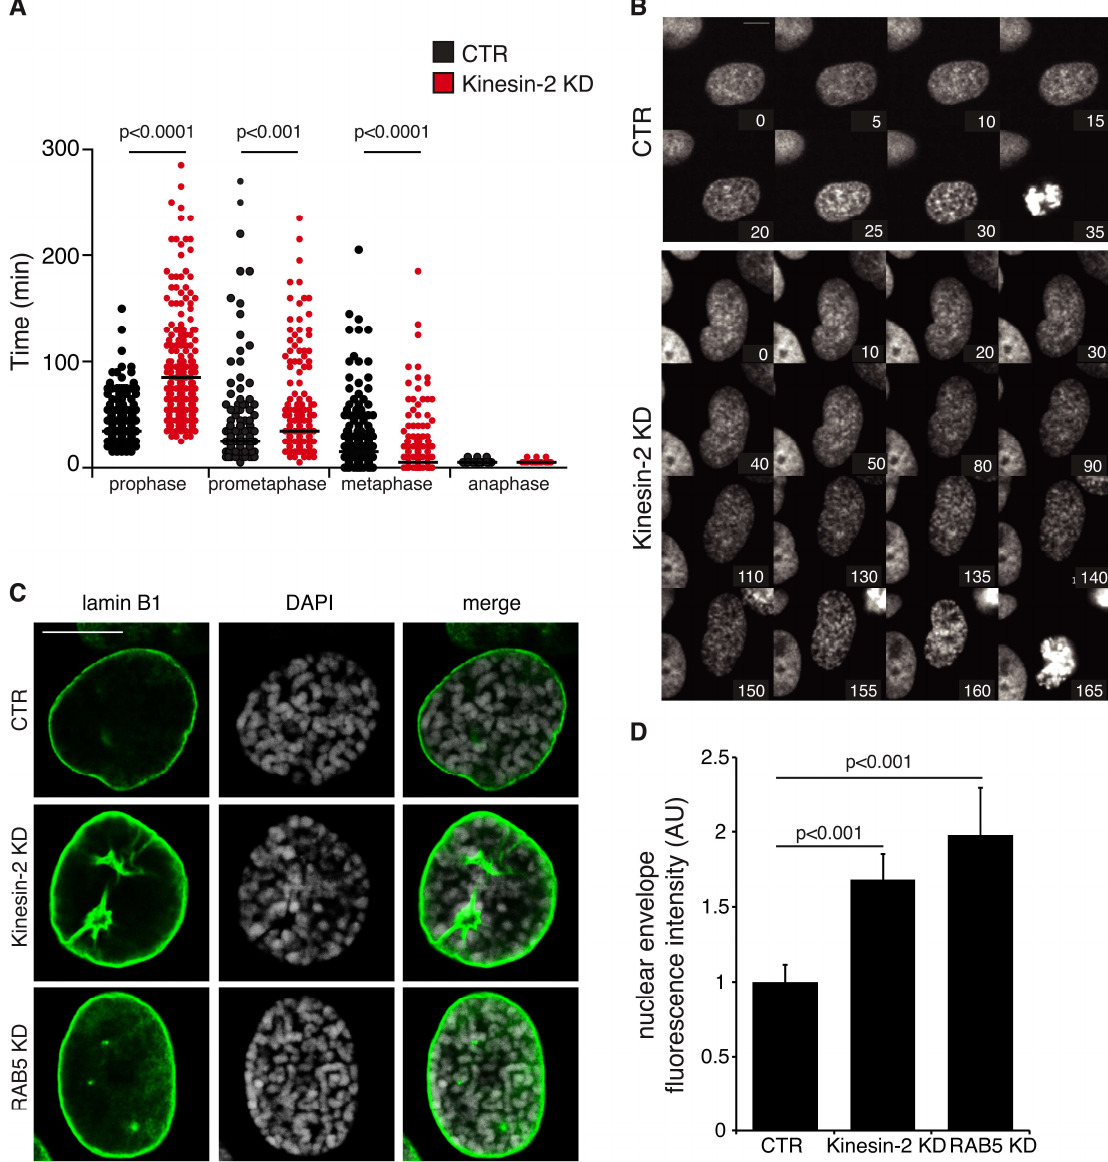
Figure 4. Kinesin-2 depletion delays prophase and nuclear envelope breakdown. ( A ) Scatter plot showing the time spent in the different mitotic phases (indicated below) by U2OS cells silenced with control oligo (CTR, n = 198 in black) or with KIF3A and KIF3B oligos (Kinesin-2 KD, n = 171, in red) from three independent experiments. ( B ) Selected frames of a single section from movies of cells stably expressing H2B-GFP silenced with control oligos (CTR; Top) or KIF3A and KIF3B oligos (Kinesin-2 KD; Bottom) showing the duration of prophase. Time is in minutes; t = 0 is defined as the time point at which chromosome condensation becomes evident. ( C ) Confocal sections of U2OS cells silenced with control oligo (CTR), KIF3A and KIF3B oligos (Kinesin-2 KD), or RAB5 oligos (RAB5 KD) at prophase stained with anti-lamin B1 (green) antibody and DAPI (gray). ( D ) Bar graph of nuclear envelope fluorescent intensity normalized over control in the cells silenced as indicated on bottom. Mean values ± SEM. Thirty-five cells per condition from four independent experiments were analyzed in CTR and Kinesin-2 KD, 19 cells from three independent experiments were analyzed in the RAB5 KD cells.